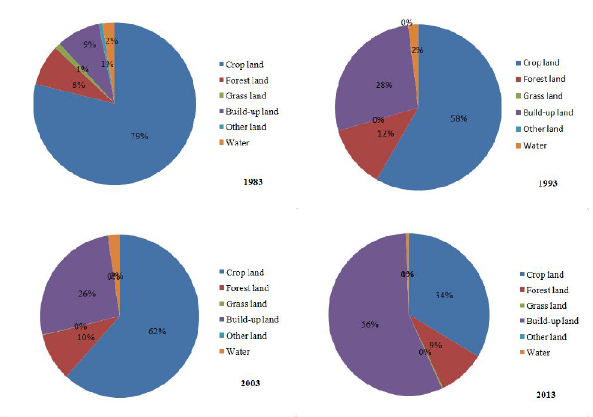
Figure.13 Temporal variation of different land cover ratio by Landsat TM between 1983 and 2013, Xibeiwang Street 5. CONCLUSIONS Based on Landsat-series data, the temporal-spatial variation of national geographic condition in Haidian district is well presented by a systematic index system. From 1983 to 2013, the crop land is gradually replaced by build-up over lower elevation and slope areas. For different development period, the rate and intensity of city extension, as well as the city morphology showed greatly variation, which is consistent with historically social and economic development. Finally, predicting the spatial distribution of land cover in the future with CA-MARKOV model can make a strategic decision for government about city development. Based on such a long time series monitoring data, more prediction analysis could be achieved further, guiding the national strategic decision making and